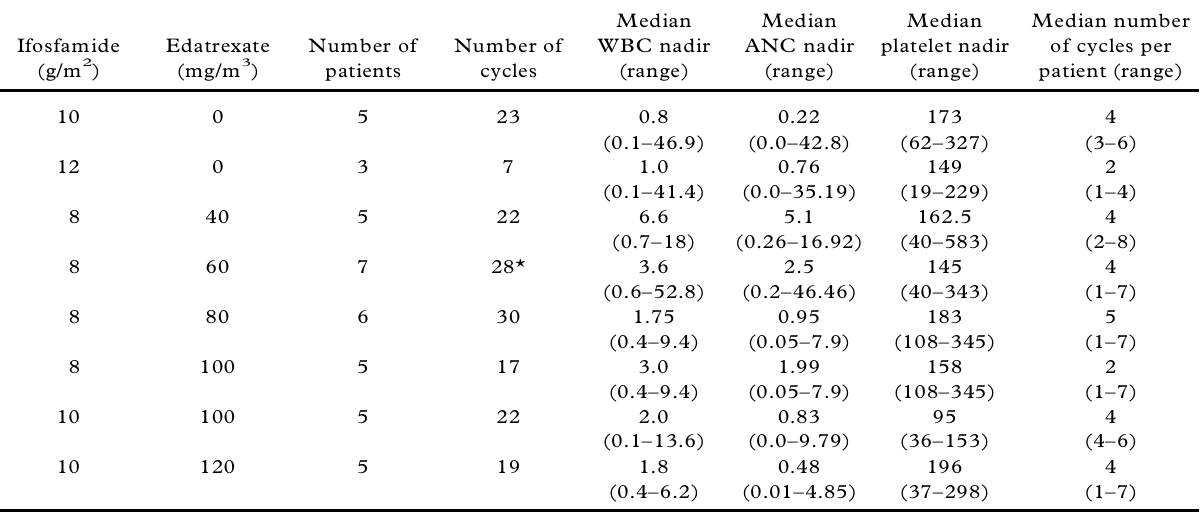
Table 4. Hematologic toxicity for all cycles of ifosfamide + G-CSF +/±